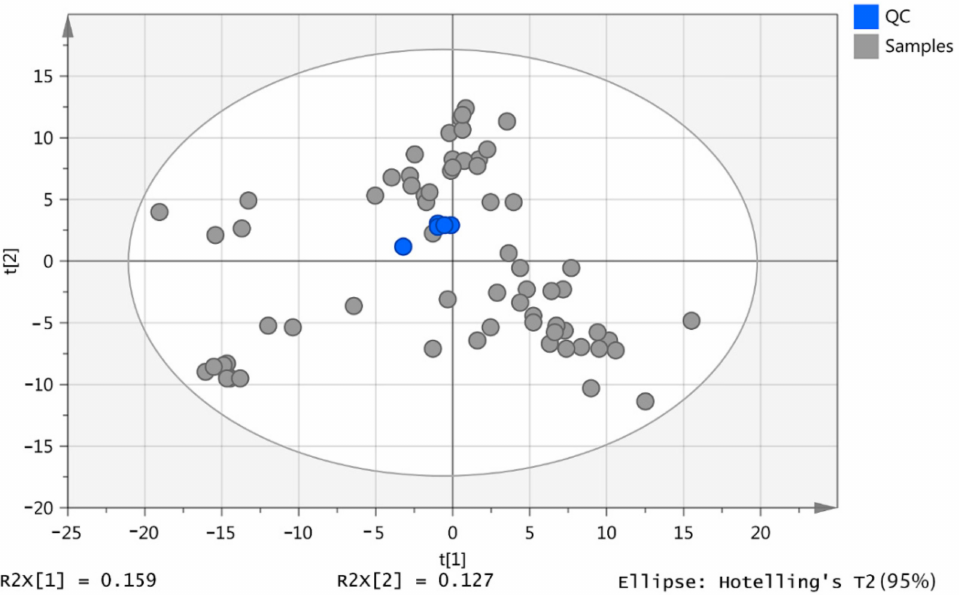
Figure 1. 2D Scores plot of the principal components analysis (PCA) for the quality control (QC) samples (blue) and all samples (grey) based on 606 putative metabolites.